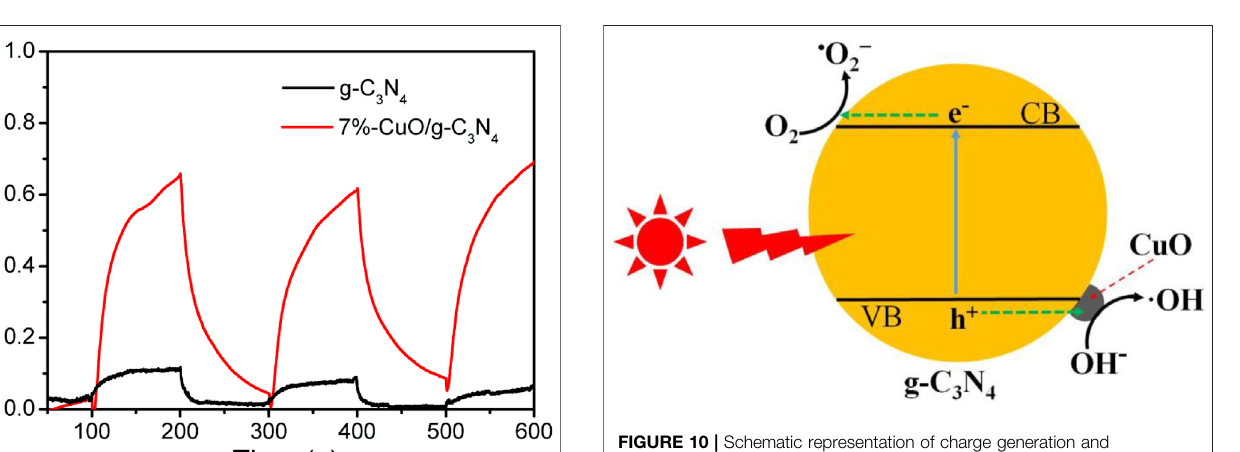
FIGURE 10 | Schematic representation of charge generation and separation in CuO/g-C 3 N 4 for the degradation of tetracycline